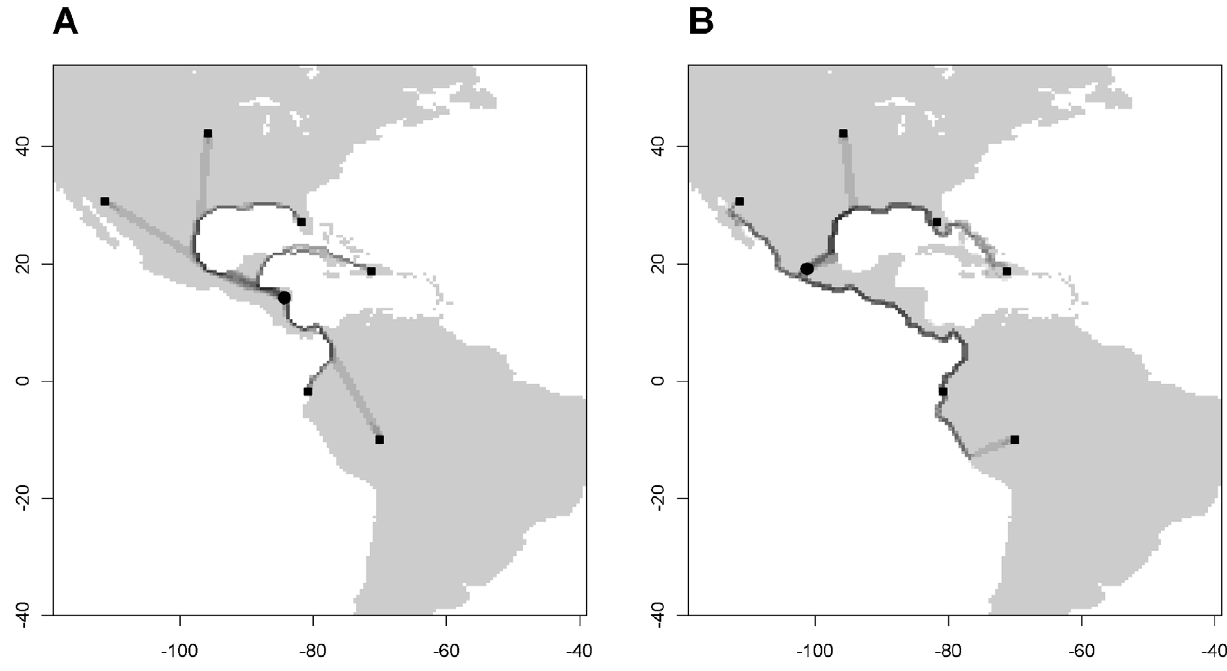
Figure 3. The dispersal routes of maize in the Americas for two contrasting Pareto solutions. Routes determined with randomized shortest paths ( h =0.2) and logarithmically scaled. A. Routes of dispersal from origin (circle) to six locations (squares) according to solution A. B. Routes of dispersal from origin (circle) to six locations (squares) according to solution I.